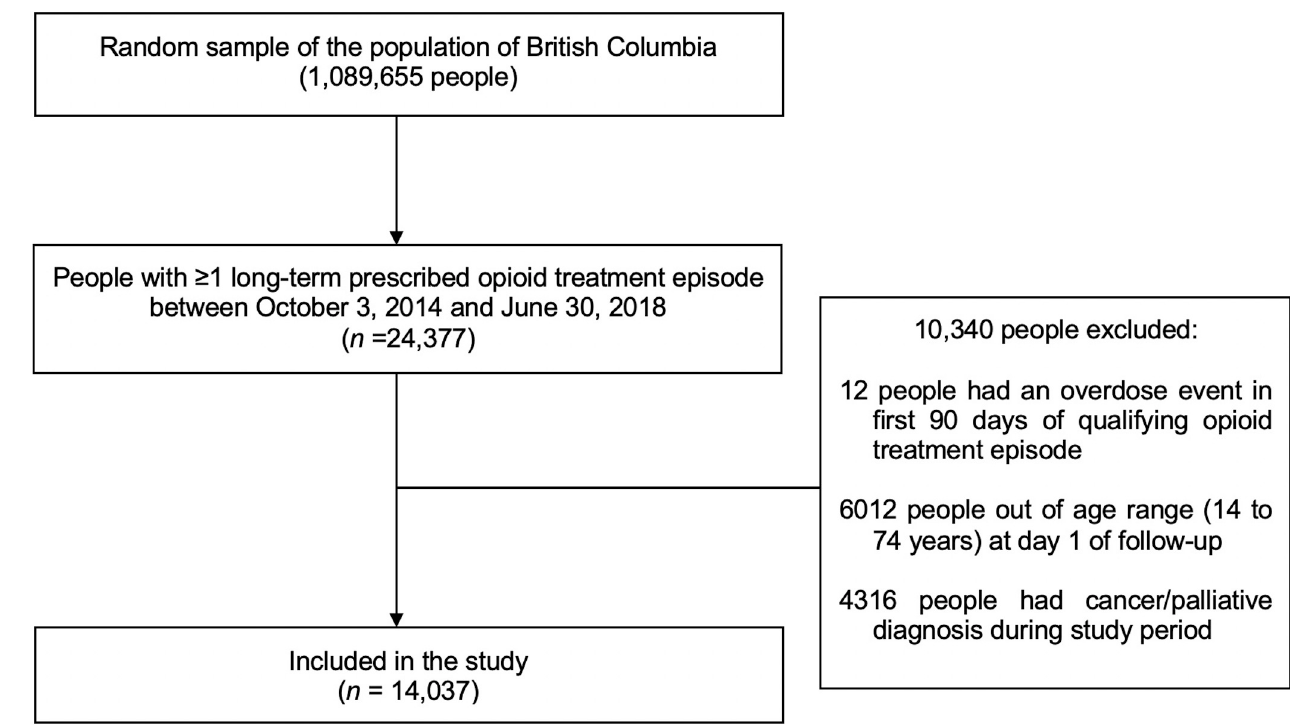
Fig 1. Flowchart showing how the analytic sample ( n = 14,037) was